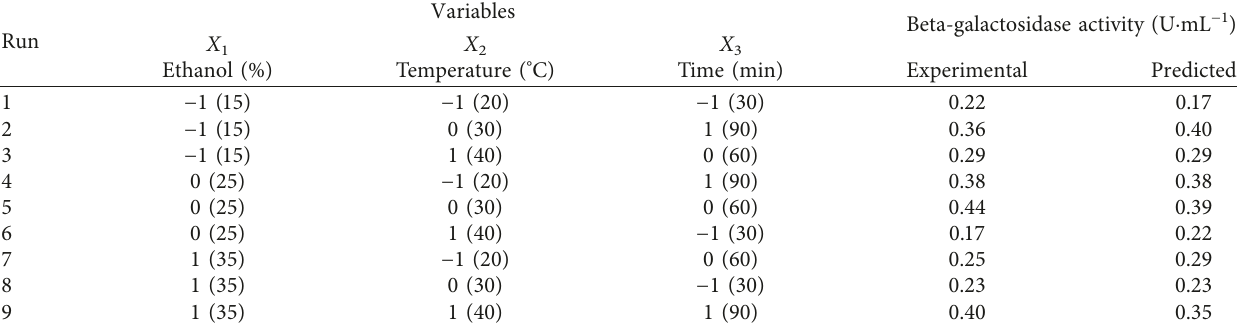
Table 1: The Box–Behnken design used to determine the effects of ethanol, temperature, and time on the enzymatic activity of permeabilized cells of Aspergillus oryzae CCT